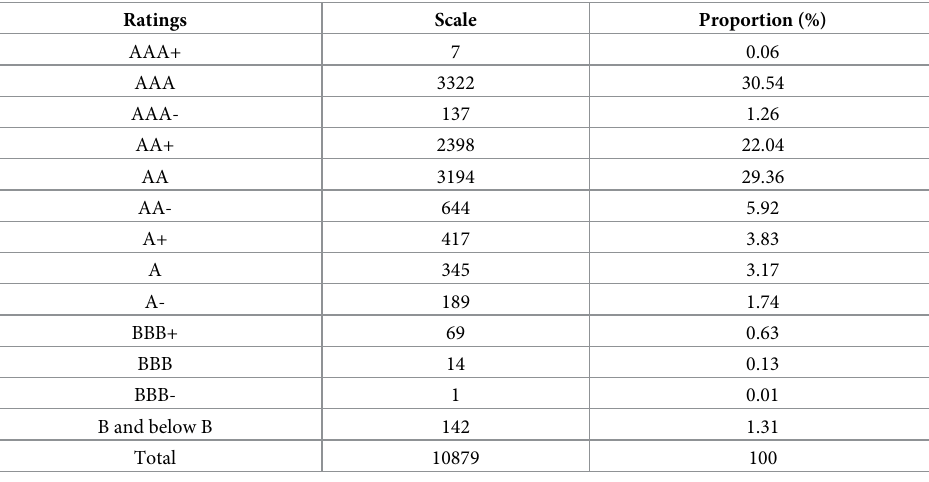
Source: Wind Economic Database.